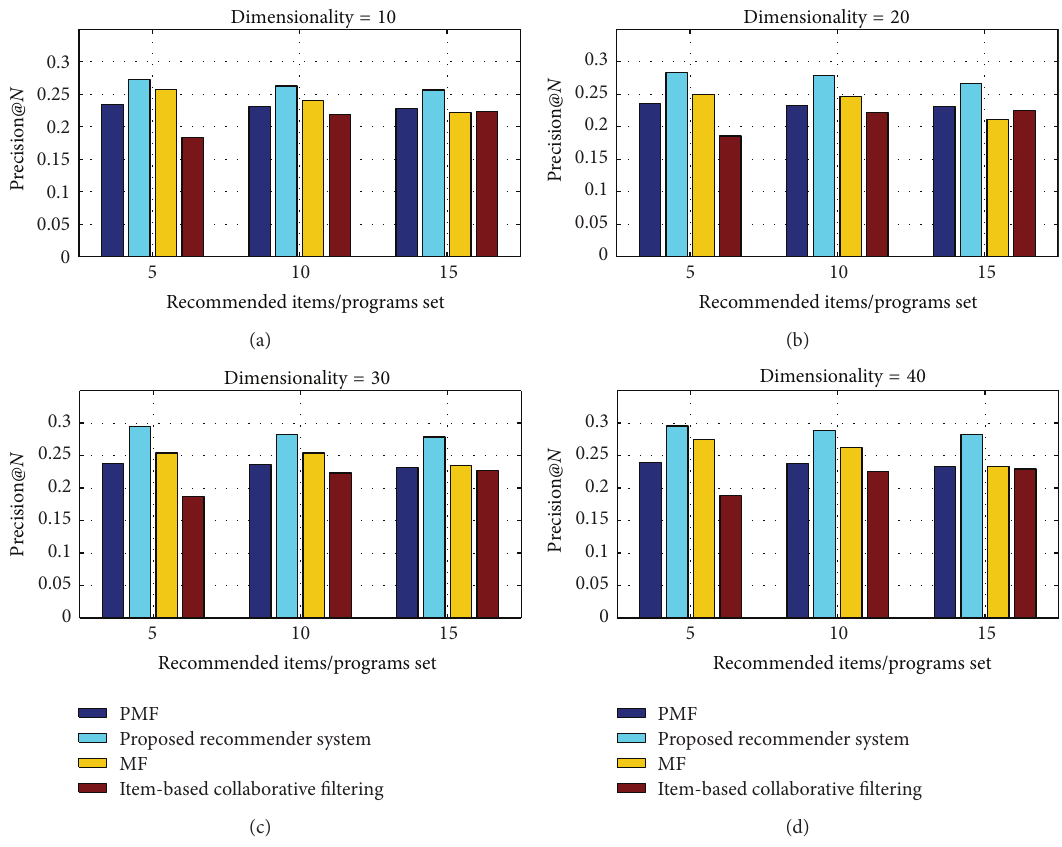
Figure 11: Comparison of precision @𝑁 ( 𝑃@𝑁 ) at different dimension of latent